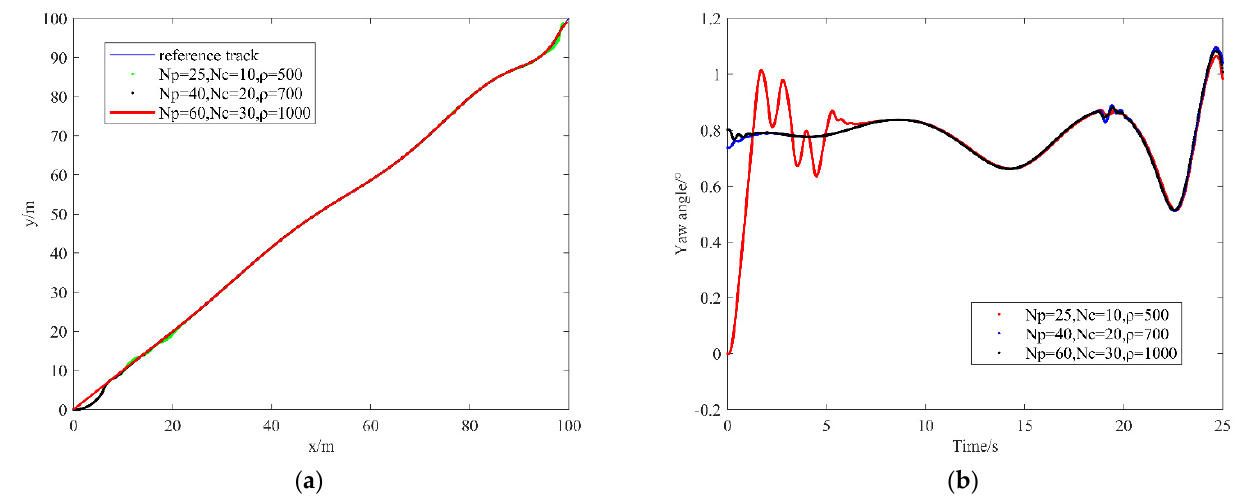
Figure 2. ( a ) Simulation of vehicle tracking reference trajectory with different controller parameters; ( b ) The yaw angle generated by the vehicle tracking the reference trajectory when the controller parameters are different.